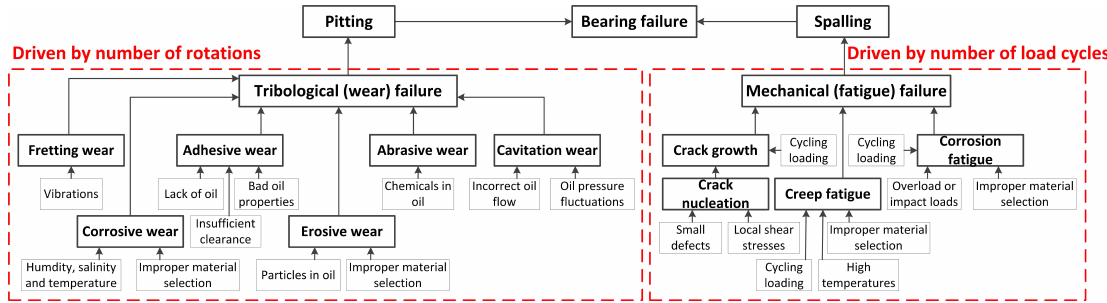
Figure 1. Example causes for bearing failures partly based on